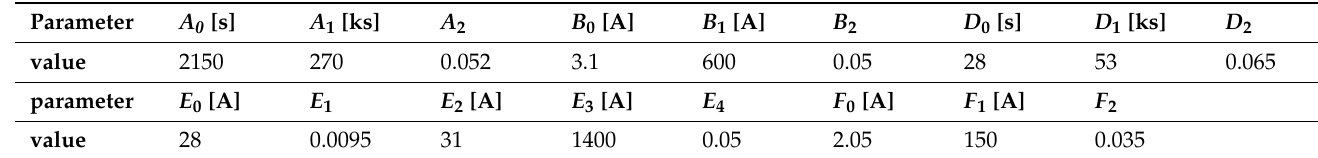
Table 2. Parameters values occurring in Formulas (11)–(15).